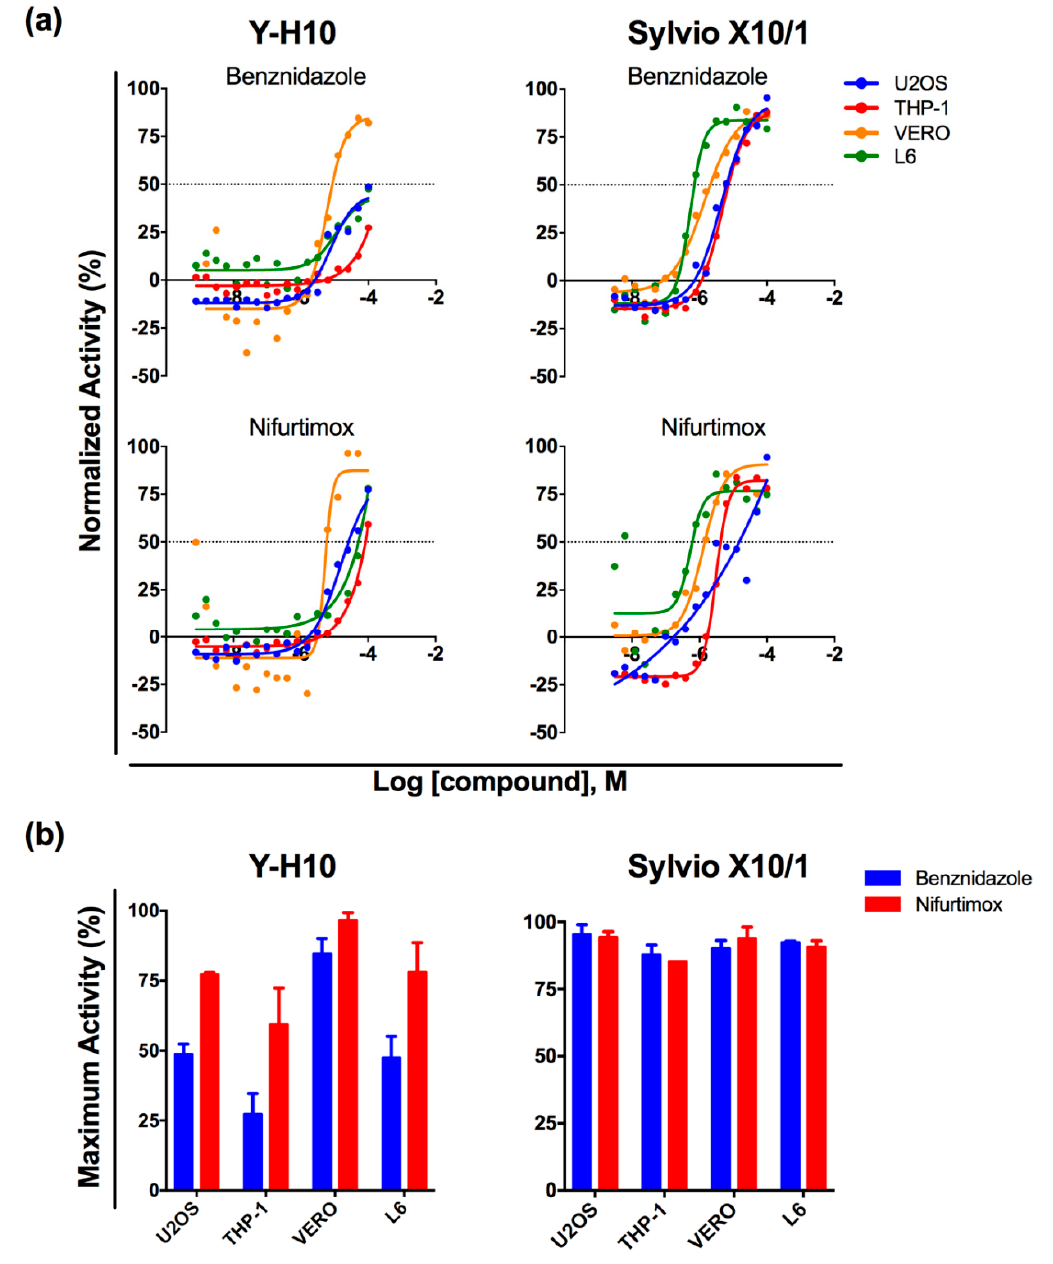
Figure 1. Activity profile for reference drugs benznidazole and nifurtimox against T. cruzi Y-H10 and Sylvio X10 / 1 infecting di ff erent host cells. ( a ) Dose-response curves for reference compounds. X-axis: compounds normalized activity (in %), Y-axis: log of compound concentration (in Molar units). Spots refer to mean values of antiparasitic activity for either Y-H10 (left) and Sylvio X10 / 1 (right) infecting U2OS (blue), THP-1 (red), Vero (orange) and L6 (green) from two independent experiments. ( b ) Maximum observed activity (Y-axis) for nifurtimox (red) and benznidazole (blue) in each host cell assay (X-axis) for T. cruzi Y-H10 (left) and Sylvio X10 / 1 (right). Data represent the means and standard deviation from two independent experiments.